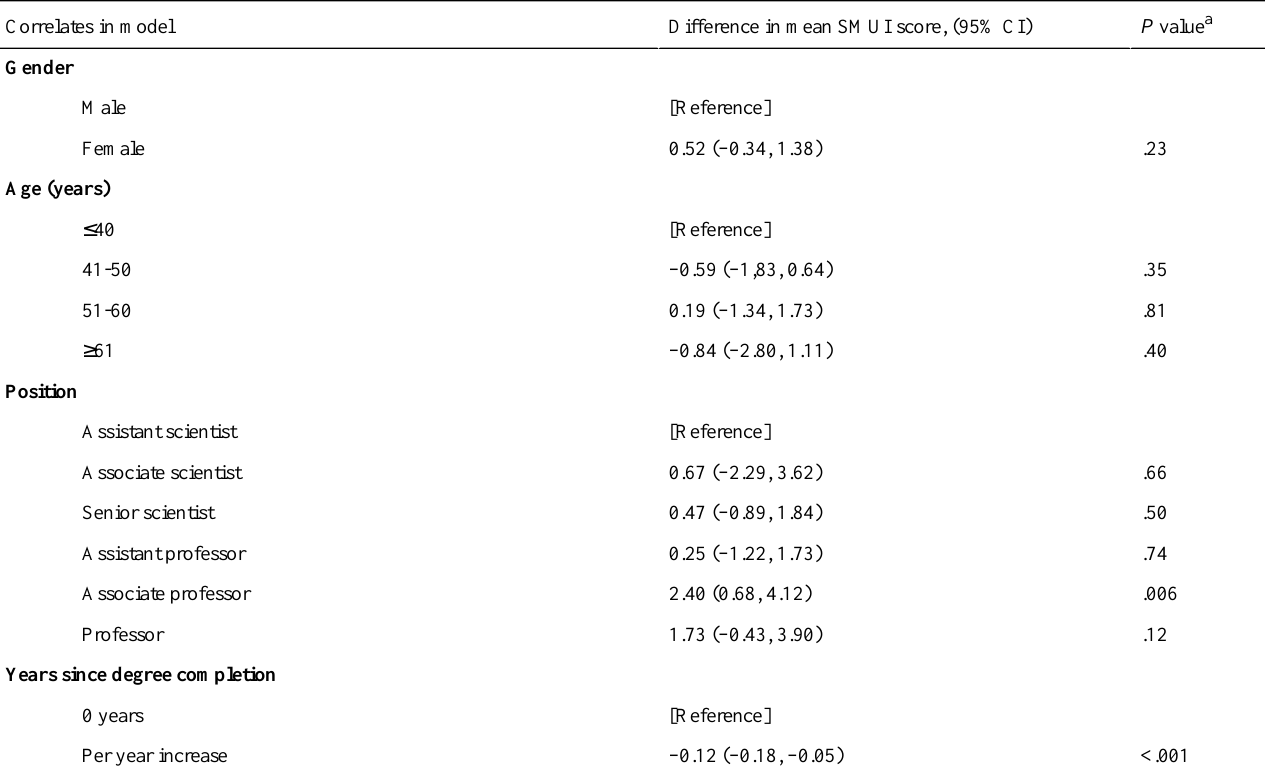
Table 2. Correlates of Social Media Usage Index (SMUI) scores in multivariate analysis.